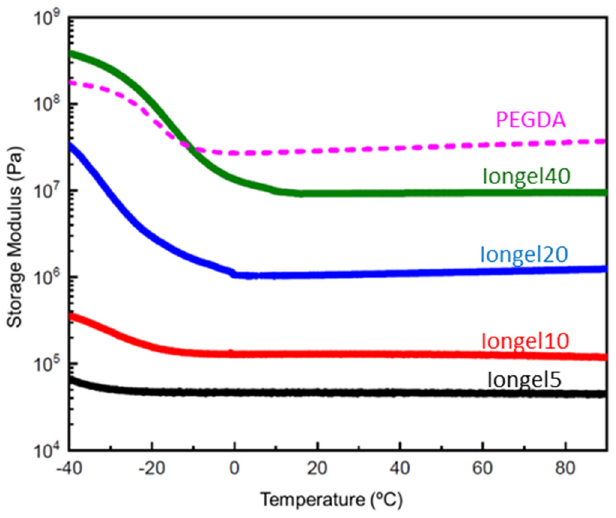
Figure 2. Storage modulus as a function of temperature for the different iongels.